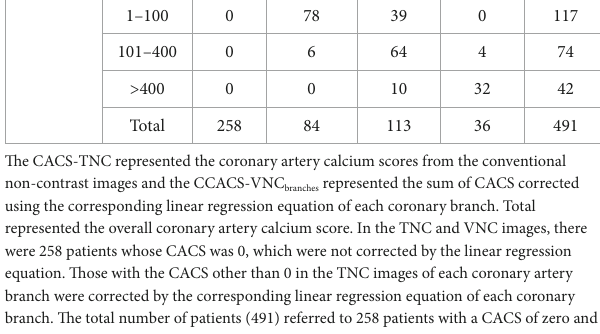
using the corresponding linear regression equation of each coronary branch. Total represented the overall coronary artery calcium score. In the TNC and VNC images, there were 258 patients whose CACS was 0, which were not corrected by the linear regression equation. Those with the CACS other than 0 in the TNC images of each coronary artery branch were corrected by the corresponding linear regression equation of each coronary branch. The total number of patients (491) referred to 258 patients with a CACS of zero and 233 patients were included in the